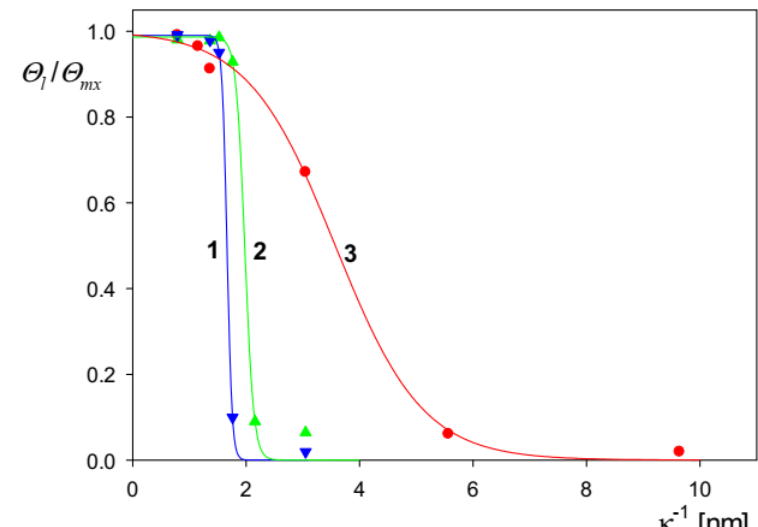
Figure 9. The normalized maximum coverage of microparticles on the saturated HSA monolayer vs. 1 κ − the electric double-layer thickness : 1 ( ) pH 7.4, 2 ( ▲ ) pH 5.5, 3 ( ● ) pH 3.5 (previous data